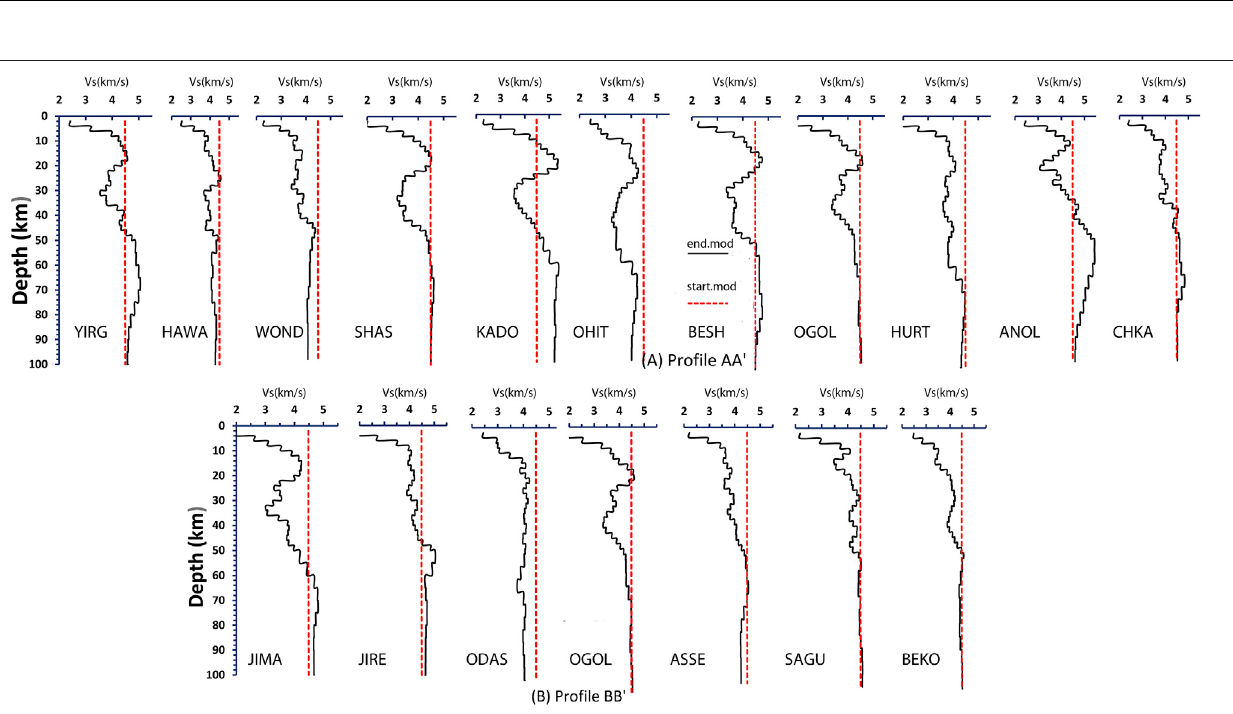
FIGURE7 | Figure (A) The 1D velocity model forthe along-rift pro fi le AA ′ ,whichis located along theeastern margin ofthe central main Ethiopian riftpro fi le. (B) The 1D velocity model for the across-rift pro fi le, which includes the rift side (JIMA, JIRE, ODAS, and OGOL) and plateau side (ASSE, SAGU, and BEKO) stations.